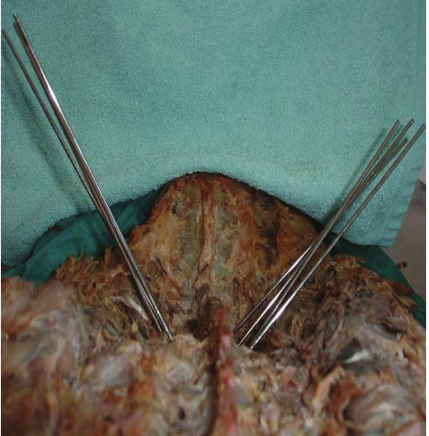
Figure 2: After removal of the primary wires which were in the correct pedicular trajectory. The 10-degree wires are on the right and the 15-degree wires are on the left.